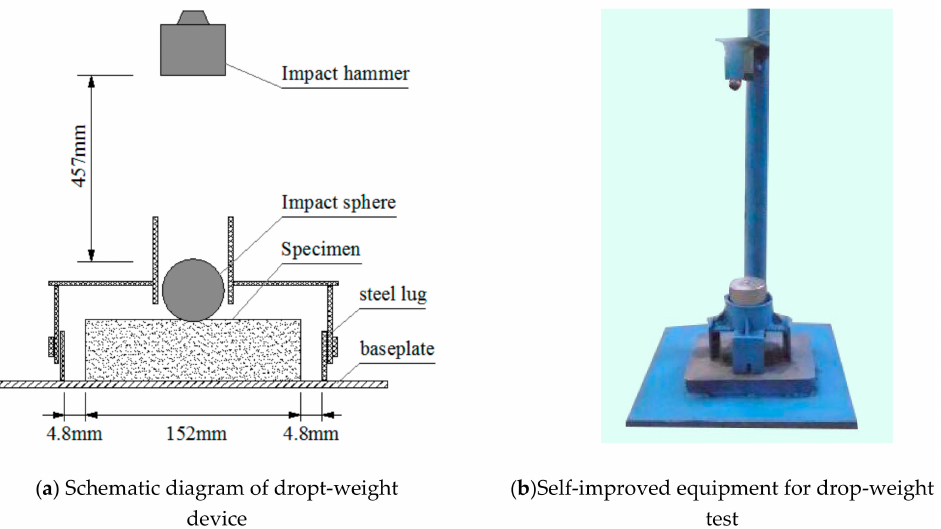
Figure 1. Drop-weight test apparatus with the cement-based material reinforced by polyvinyl alcohol fiber PVA-FRCM disc.